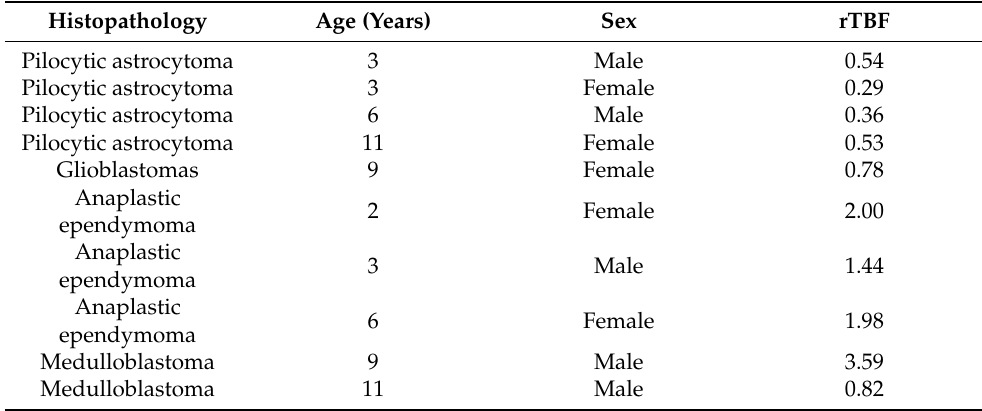
Table 11. rTBF values for different pediatric tumors according to age